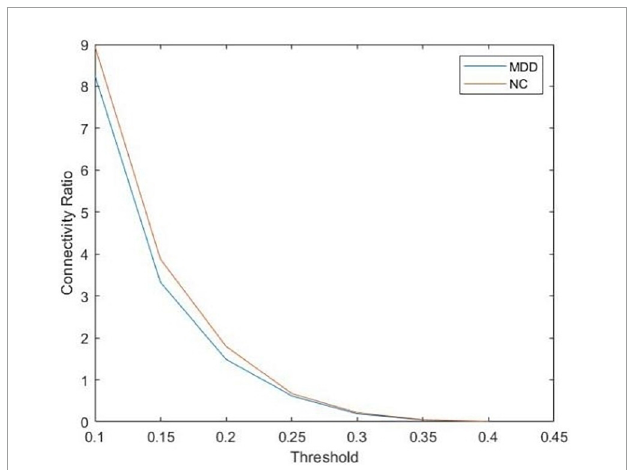
FIGURE2 The quantitative ratio curve of brain network connectivity of subjects. The connectivity ratio is the ratio of the number of connected brain networks to the number of unconnected ones for major depressive disorders (MDD) or normal control (NC). With the increase in the threshold, the number of connected graphs dwindled.